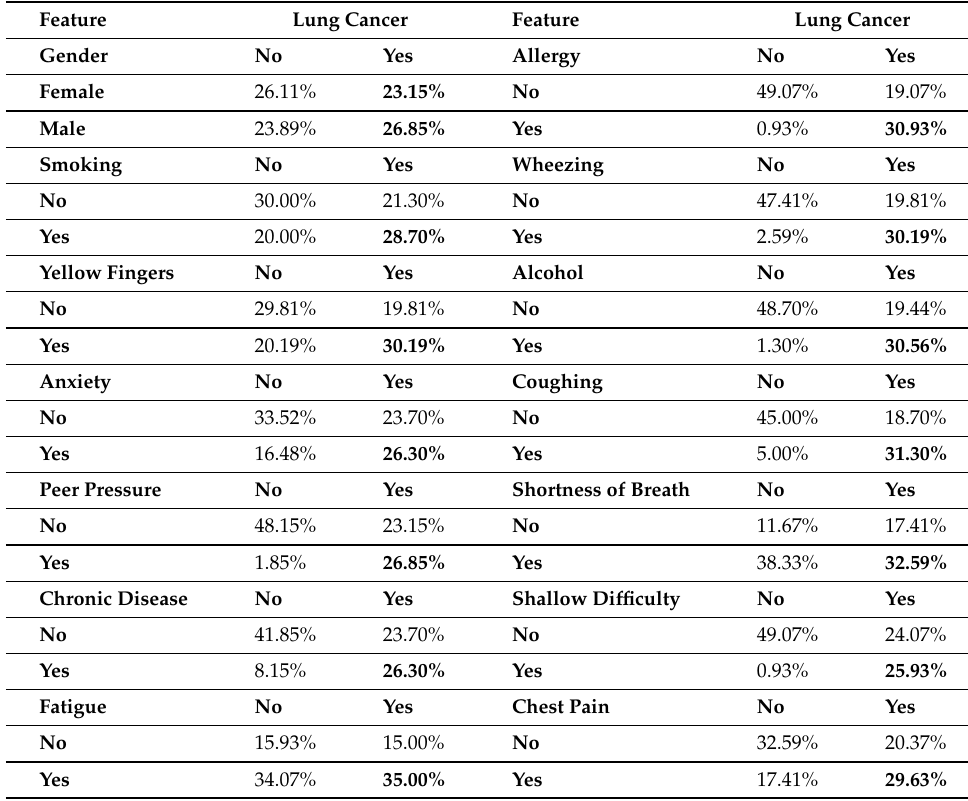
Table 2. The distribution of participants in terms of feature values and class label in the balanced